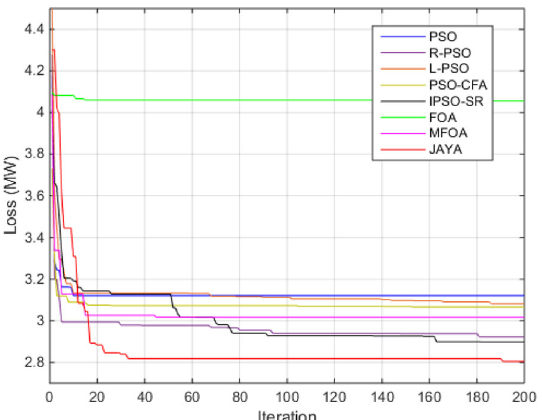
Fig. 11 Convergence characteristics of the algorithms for the IEEE 30 bus system with underestimated Weibull probability distribution function of wind power on